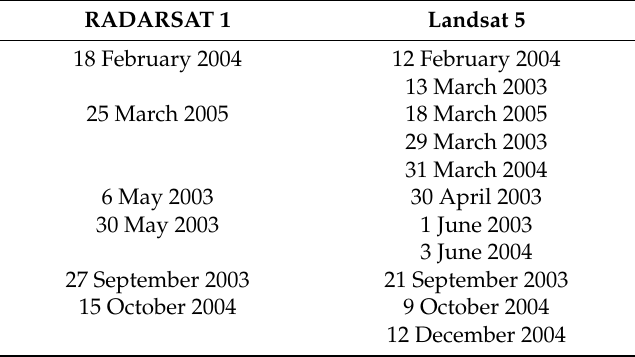
Table 2. Acquisition dates of satellite data at site